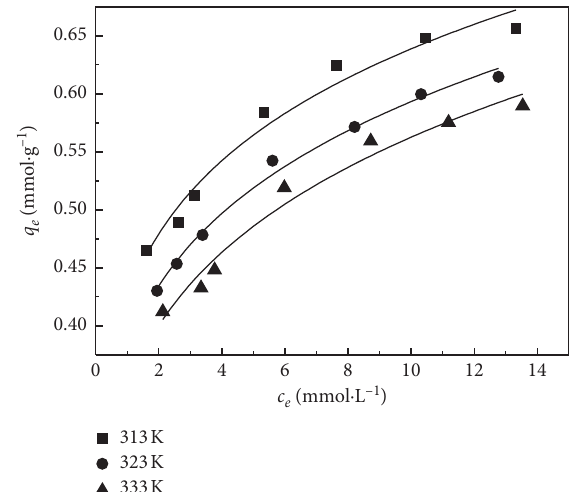
Figure 13: Nonlinear fitting of Temkin model (adsorbent: 0.2g : 20 mL; c 0 : 6.25, 7.81, 9.38, 12.50, 15.63, 18.75, and 2 wt. %; v oil 21.88mmol · L − 1 DBT; adsorption time: